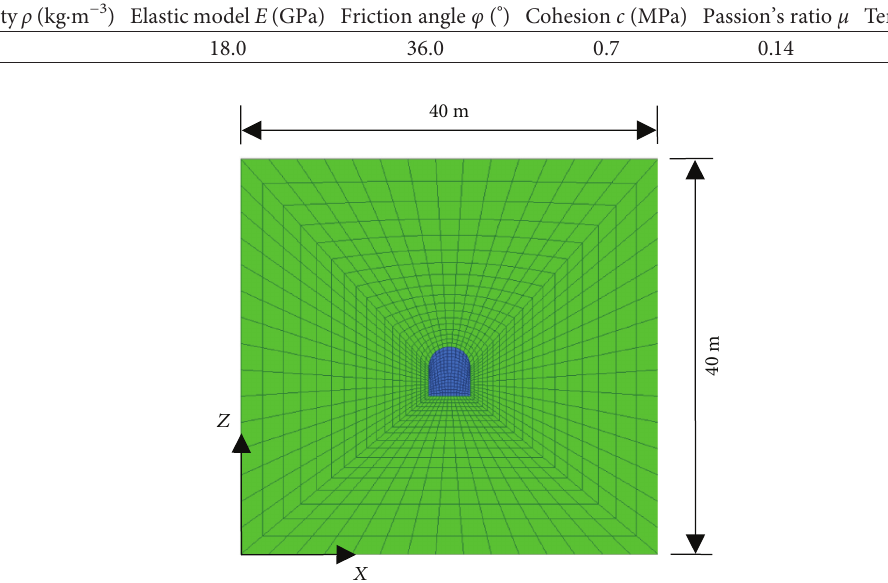
Figure 5: Model and grid partition